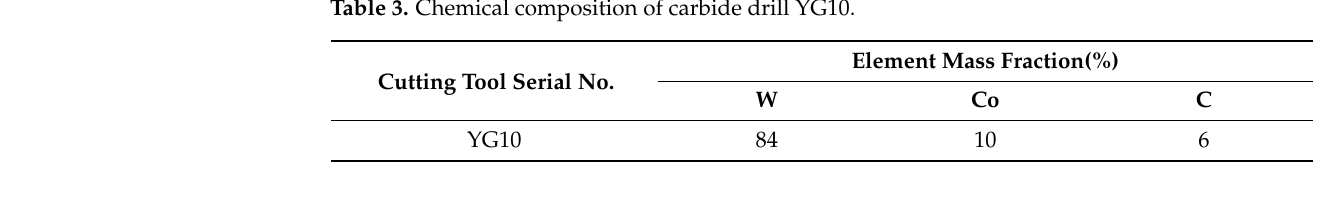
Table 4. Mechanical properties of carbide drill